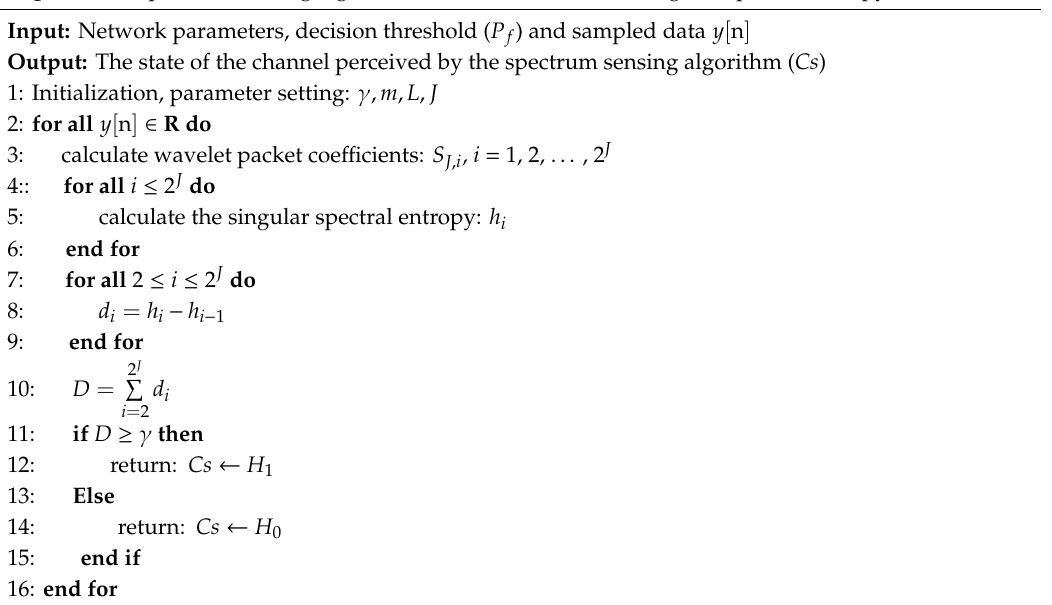
Algorithm 1 Spectrum sensing algorithm with multi-resolution singular spectral